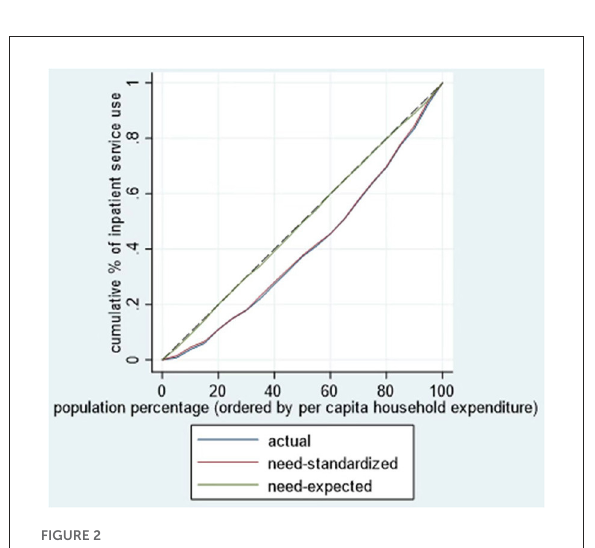
FIGURE2 Concentration curve for use of inpatient services among cancer